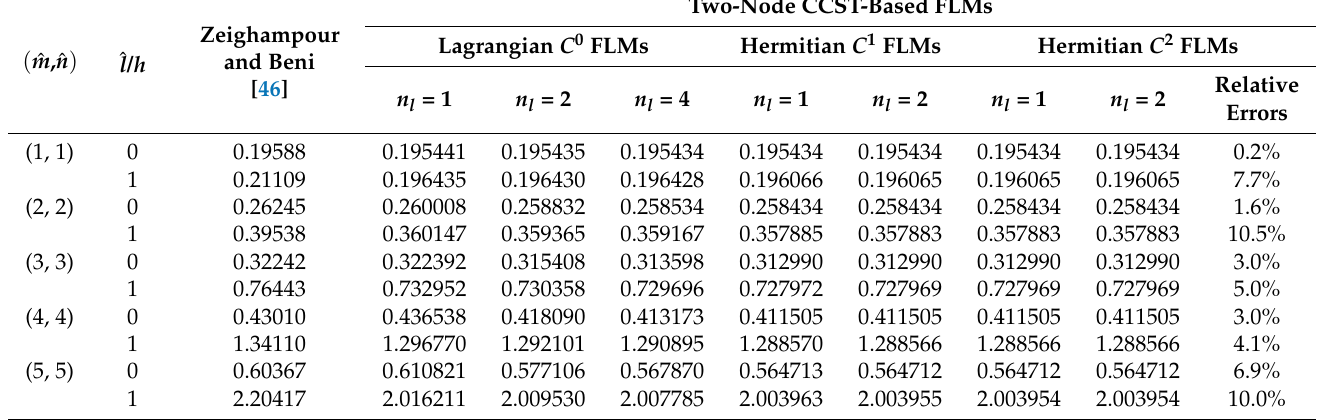
Table 1. Convergence and validation studies for the lowest frequency parameter solutions of simply- supported, homogeneous isotropic SWCNTs obtained using two-node CCST-based FLMs and the MCST-based LCST, where h / R =